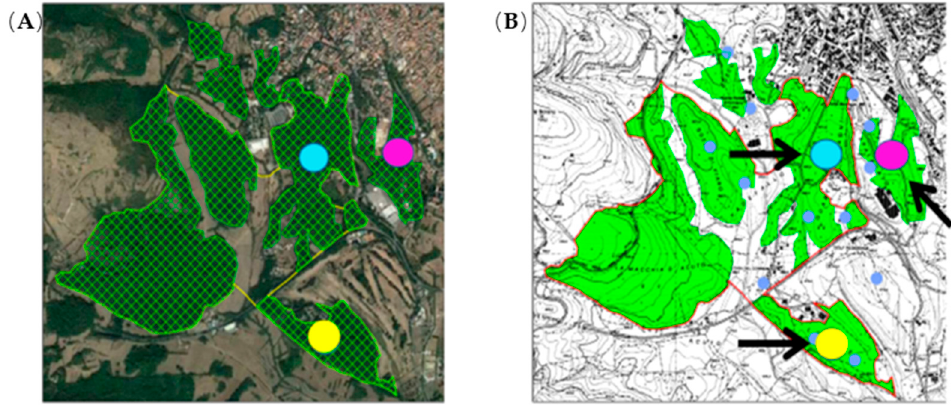
Figure 2. ( A ) Forest areas of the municipality of Fiuggi above the mineral water aquifers and soil sampling points: Quarto d’Anagni; Le Prata or Lagozzo; Le Cese. ( B ) Spring of Fiuggi mineral waters.